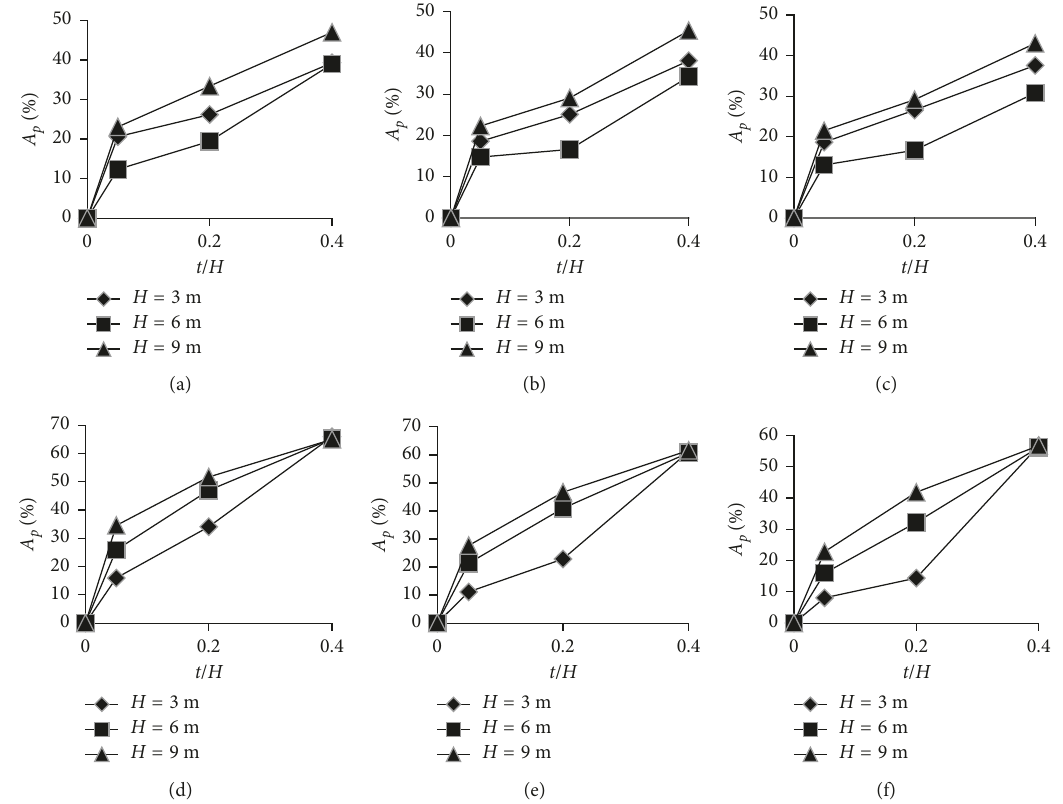
Figure 4: Influence of the geofoam thickness ratio on (a, b, and c) reduction of forces on the yielding retaining walls and (d, e, and f) reduction of forces on the nonyielding retaining walls. (a) EPS15. (b) EPS20. (c) EPS25. (d) EPS15. (e) EPS20. (f)